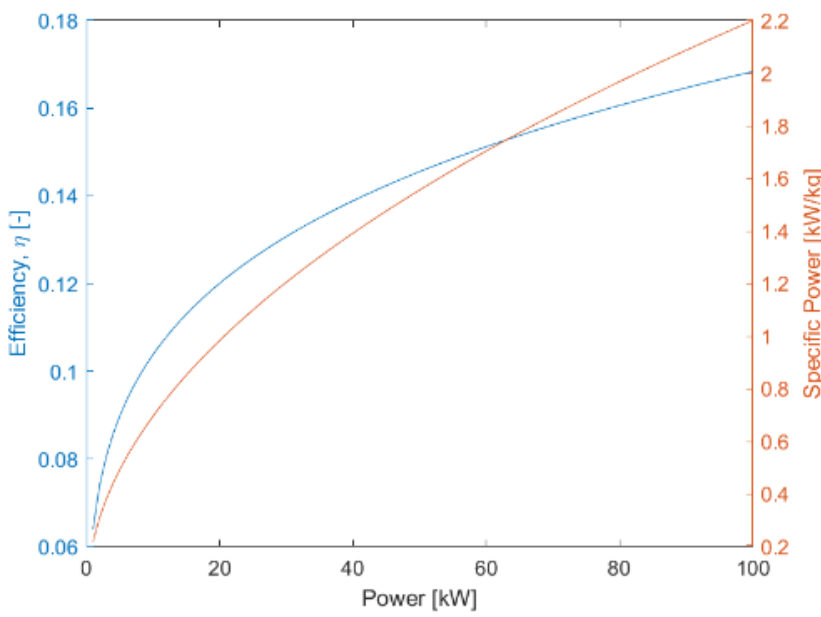
Figure 8. Non-linear turbo-engine surrogate model.